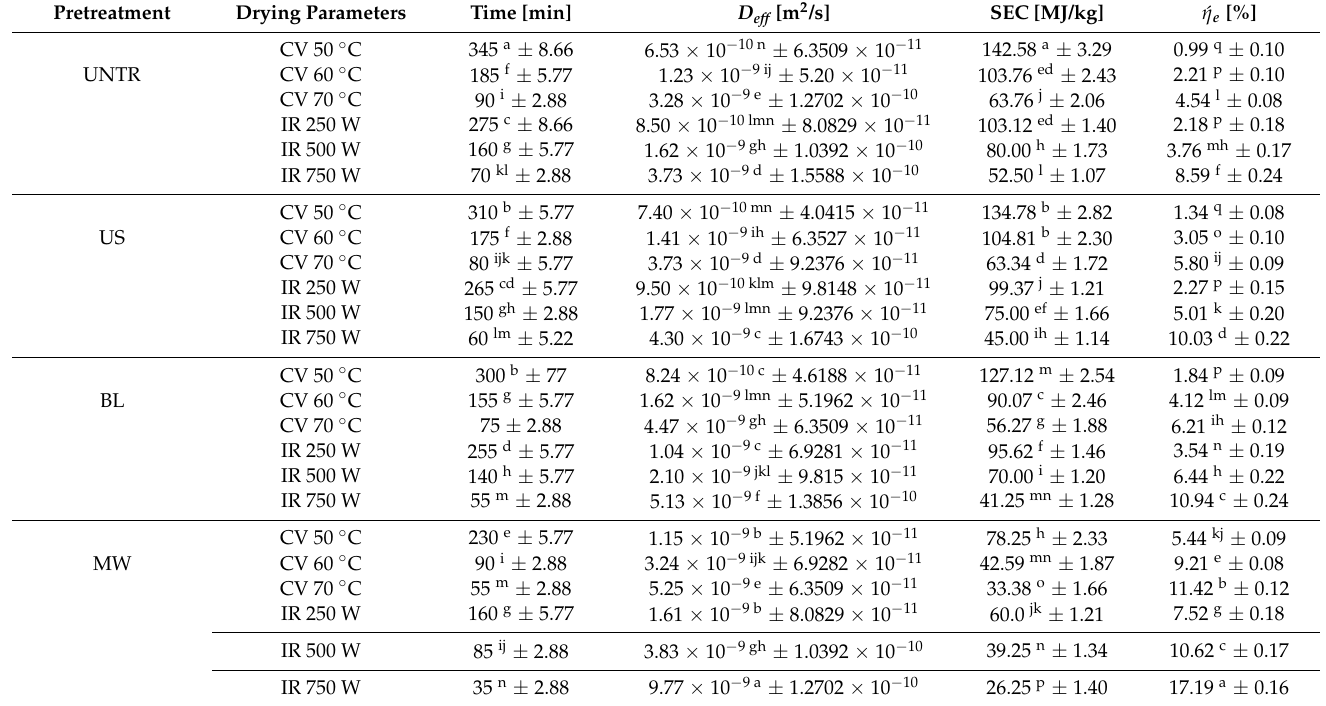
Table 3. Results of time, effective moisture diffusivity coefficient ( D eff ), specific energy consumption (SEC), and energy efficiency ( ´ η e ) of terebinth samples under different pretreatments and different conditions of drying methods.